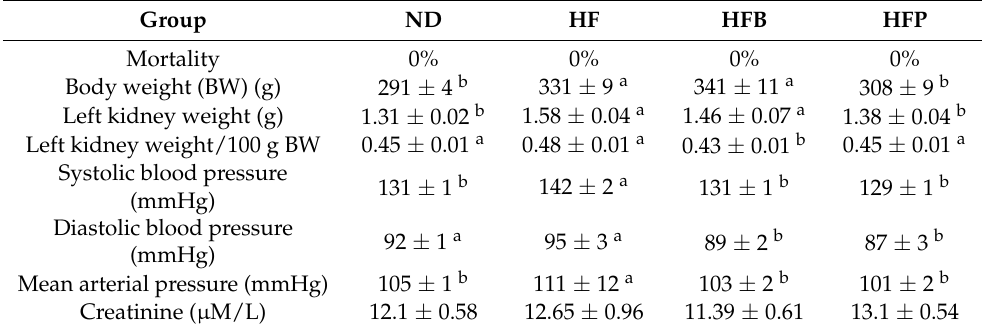
Table 2. Weights, BP, and the creatinine concentration of male offspring at 12 weeks of